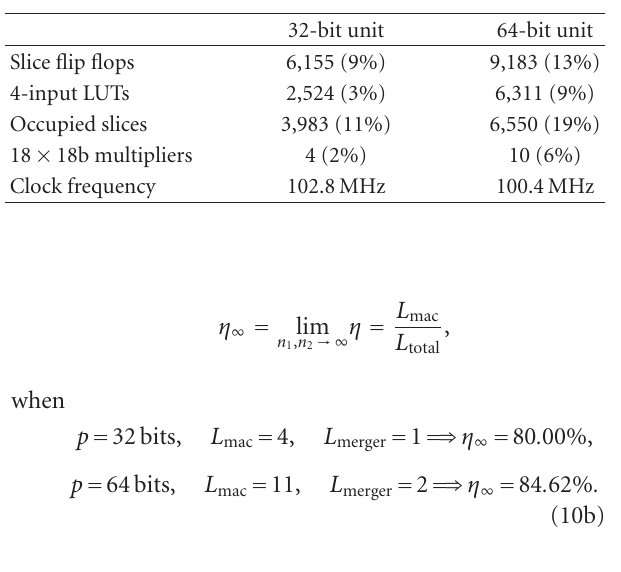
Figure 10: Pipeline e ffi ciency. Table 2: FPGA resource utilization.